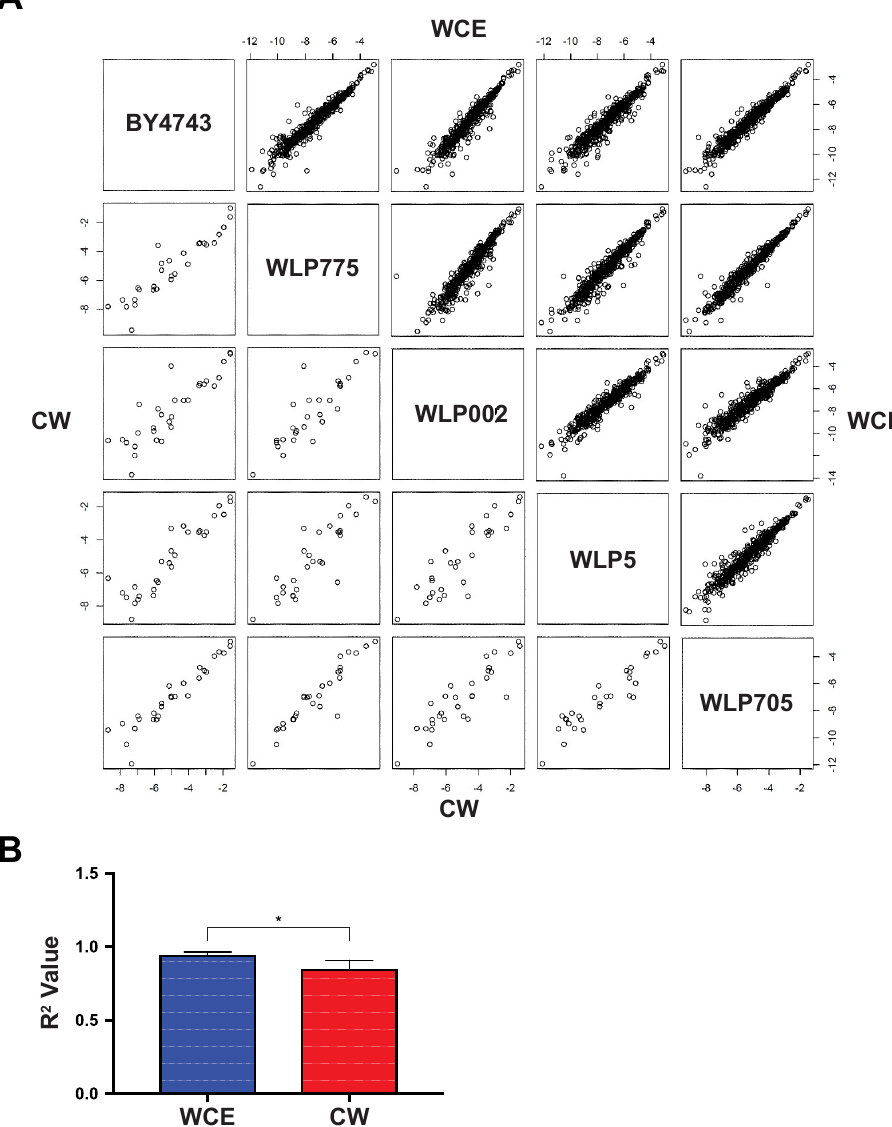
Figure 3. Pairwise comparison of yeast cell wall and whole cell proteomes. ( A ) Pairwise scatter plots of the natural logarithm normalized mean relative abundance for identified proteins between all strains. Cell wall proteome ( n = 30) data are in the bottom left plots, while whole cell proteome ( n = 468) data are in the top right plots; ( B ) R 2 correlation plot. Error bars, SD. * p <